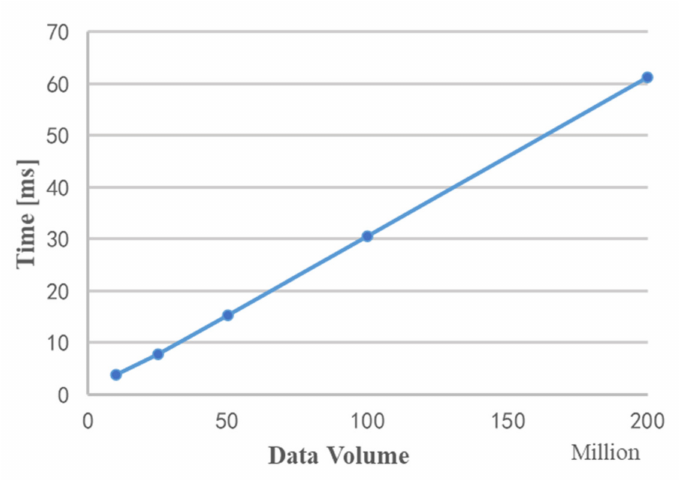
Figure 11. Time chart for data